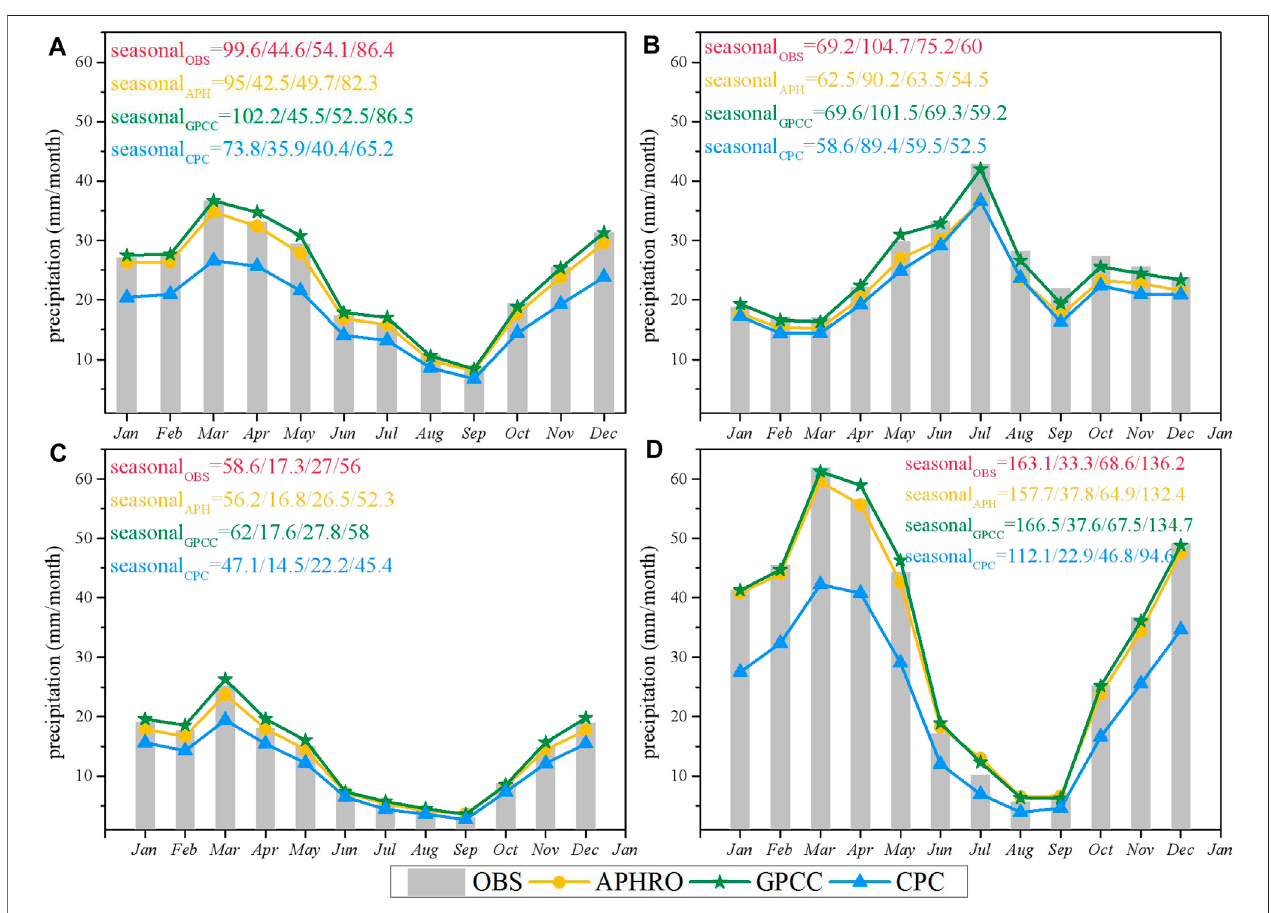
FIGURE 6 | The annual cycle of the OBS (gray columnar), APHRODITE (yellow circled line), GPCC (Green pentagonal line), and CPC (Blue line with triangles) precipitation over the CA (A) and sub-regions (B) , NCA; (C) , SWCA; (D) , SECA during 1985 − 2005. (The numbers in the upper left corner of each sub- fi gures represent the regional average precipitation in spring, summer, autumn and winter calculated by each product,